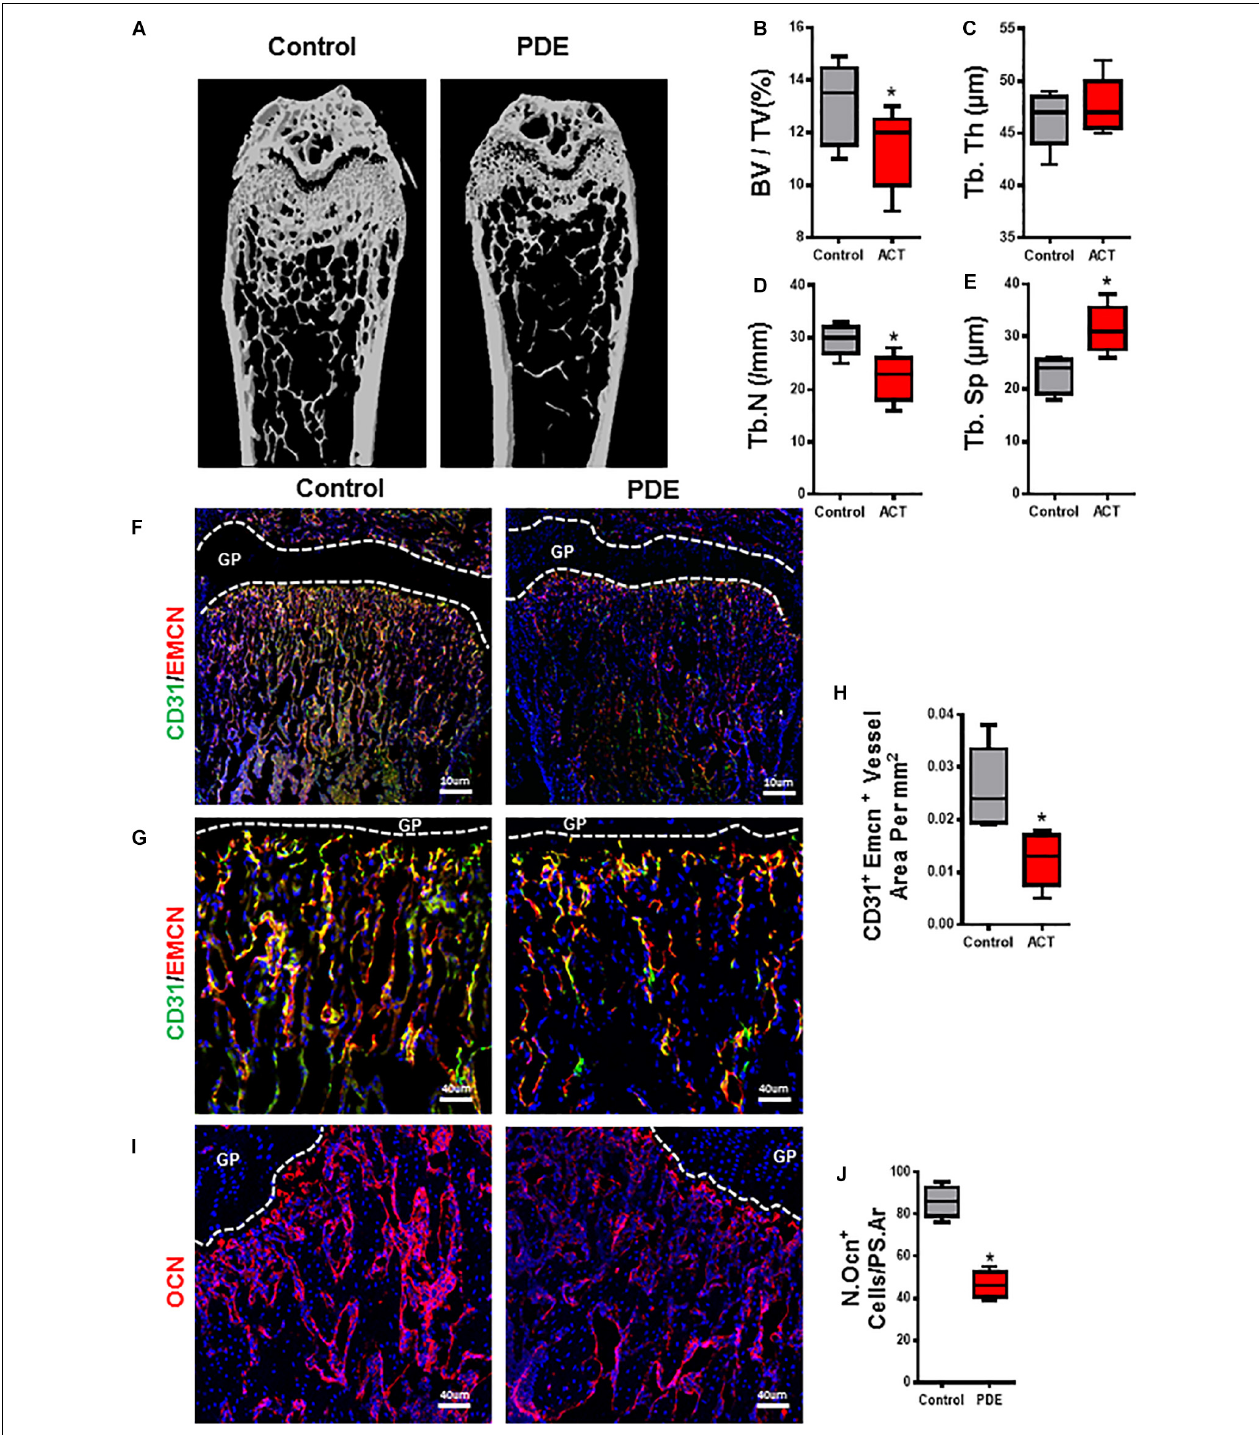
FIGURE 1 | Prenatal dexamethasone exposure decreases bone volume and angiogenesis in long bone. Representative µ CT images of distal femur in 12-week-old female mouse offspring are shown in panel (A) . Quantitative analyses of femoral microstructural parameters of female mouse offspring including trabecular bone volume fraction (BV/TV) (B) , trabecular number (Tb. N) (C) , trabecular thickness (Tb. Th) (D) , and trabecular separation (Tb. Sp) (E) . (F,G) Representative images of double-immunofluorescence staining for CD31 (green) and endomucin (Emcn, red) in femoral metaphysis from 12-week-old female offspring. DAPI stains nuclei blue. Images in panel (F) are lower power with boxes outlining the area of higher power in panel (G) . Quantification of the relative fluorescence area of CD31 + Emcn + cells per tissue area in femoral metaphysis (CD31 + Emcn + area per mm 2 ) (H) . (I) Representative images of immunofluorescence staining for osteocalcin (red) and (J) quantitative analysis of osteocalcin + cells in femoral metaphysis from 12-week-old female offspring. DAPI stains nuclei blue. * p < 0.05.